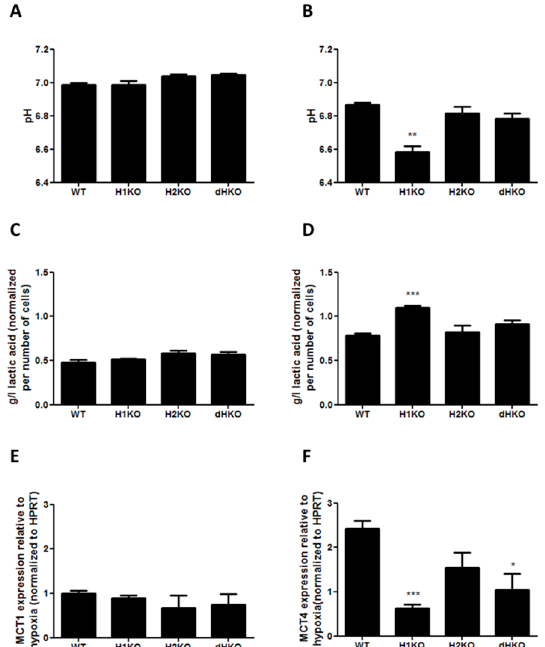
Figure 6. ( A , B ) Measurement of extracellular pH and ( C , D ) extracellular L-lactic acid accumulation upon normoxia (left panels) or hypoxia (right panels). Values were normalized to total cell number. mRNA expression of HIF target genes MCT1 ( E ) and MCT4 ( F ) after 24 h hypoxia incubation. HPRT was used as housekeeping gene to normalize expression data. Asterisks indicate statistical significance (* p < 0.05; ** p < 0.01; *** p < 0.001).